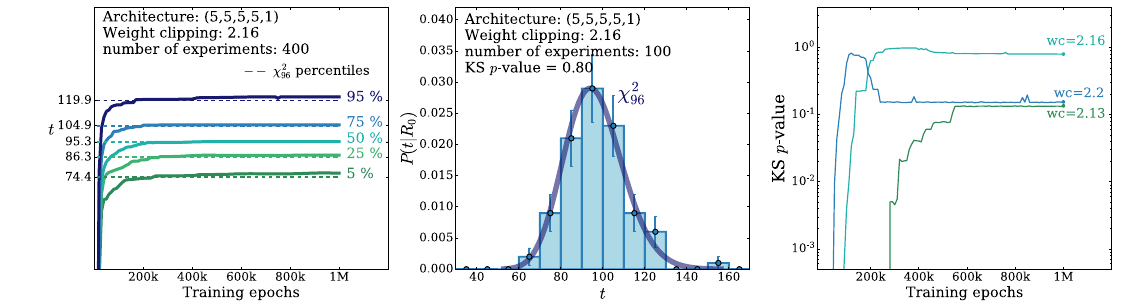
Fig. 9 Left panel: Percentiles of the empirical t distribution for the ( 5 , 5 , 5 , 5 , 1 ) network, with 100 toys, as a function of the number of training epochs for the optimal value (2 . 16) of the weight clipping